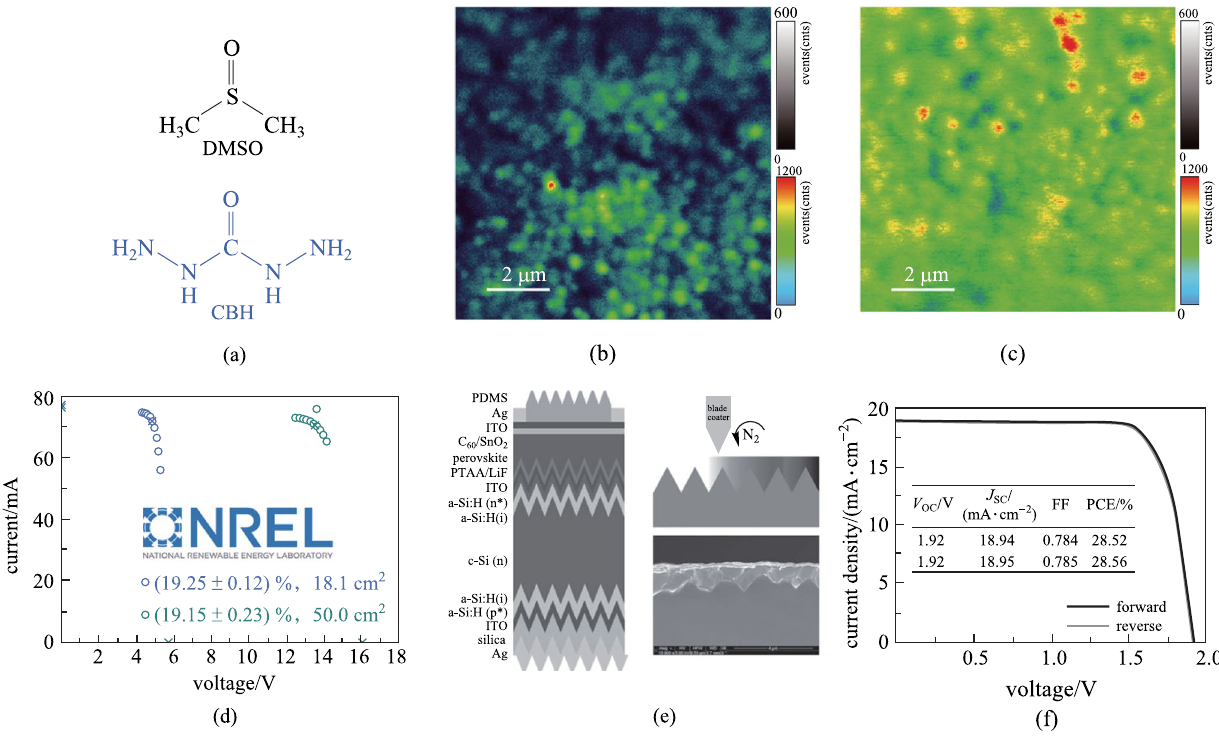
Fig. 4 a Chemical structures of DMSO and CBH. photoluminescence maps of the control b and target c perovskite films on thin glass excited from the glass side with a 485-nm laser. d NREL certified stabilized current–voltage dots around the MPP point of the minimodules with aper- ture areas of 18.1 and 50.0 cm 2 . e Device structures and cross-sectional SEM images of blade-coated perovskite–silicon tandem cells based on doped-PTAA. f J – V curves of champion monolithic perovskite–silicon tandem solar cell. a – d Reprinted with permission from Ref. [46]. Copy- right 2021, The American Association for the Advancement of Science. e , f Reprinted with permission from Ref. [48]. Copyright 2022, Springer